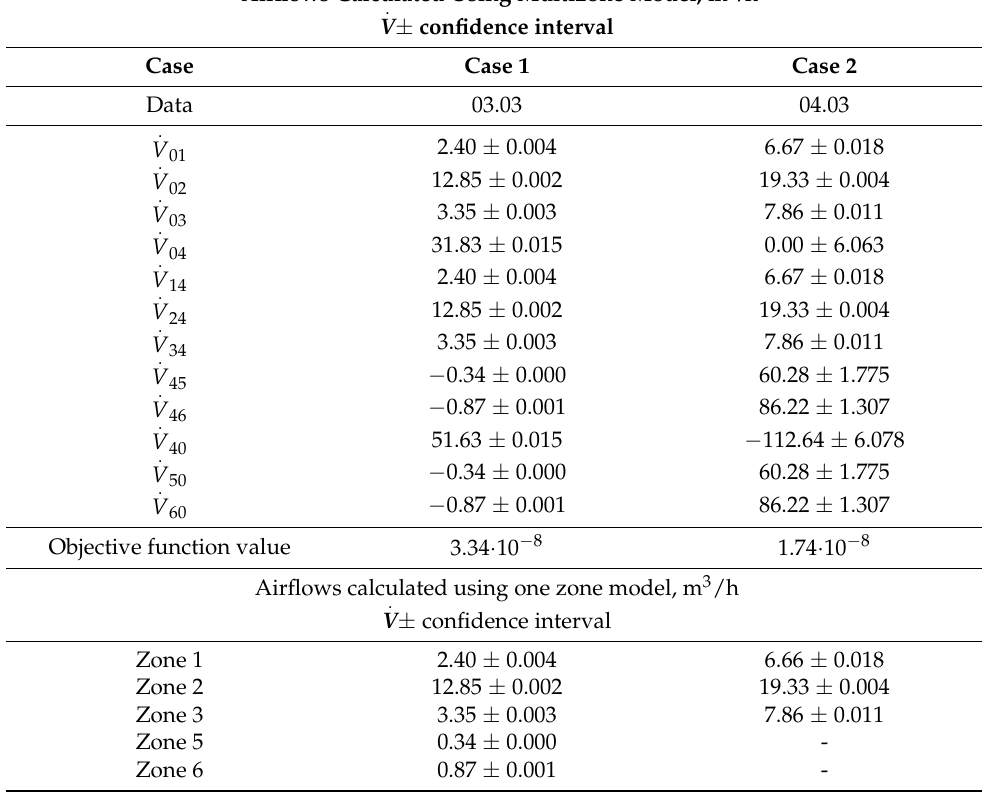
Table 5. Results of the estimated airflows in apartment II for selected monotonic fragments of CO 2 concentration curves. Airflows Calculated Using Multizone Model, m 3 /h